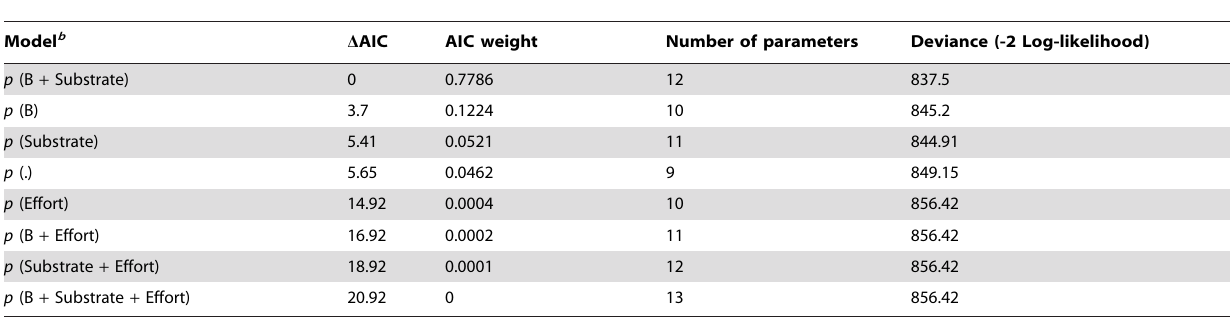
Table 2. Effect of covariates a on detection probability ( ^ pp